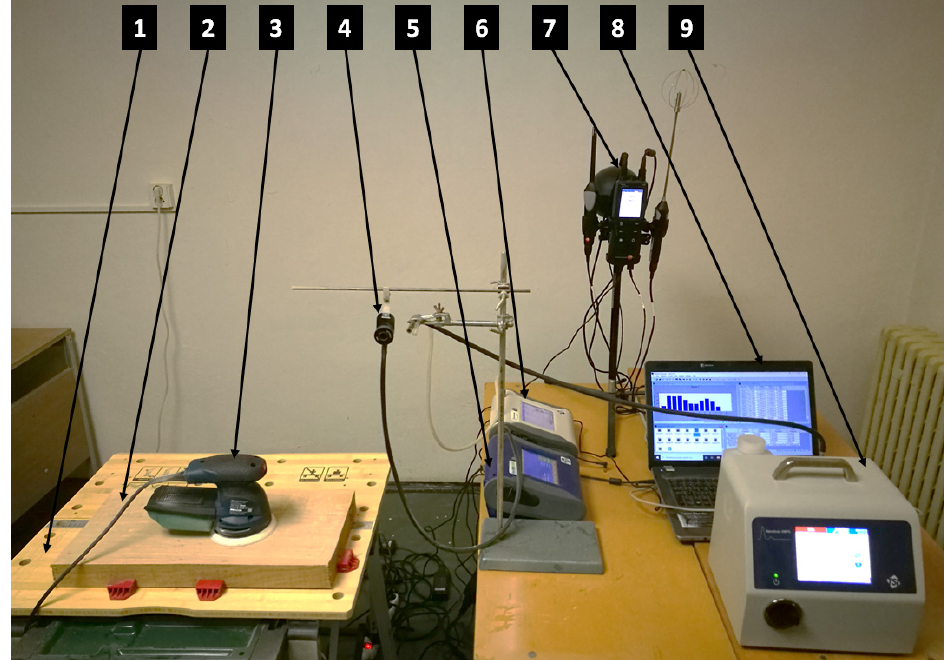
Figure 1. Layout of experimental setup: 1—workbench, 2—test specimen, 3—sander, 4—IOM sam- pler, 5—aerosol monitor, 6—optical particle sizer, 7—microclimatic condition monitor, 8—software tool for data processing, 9—nanoparticle sizer.